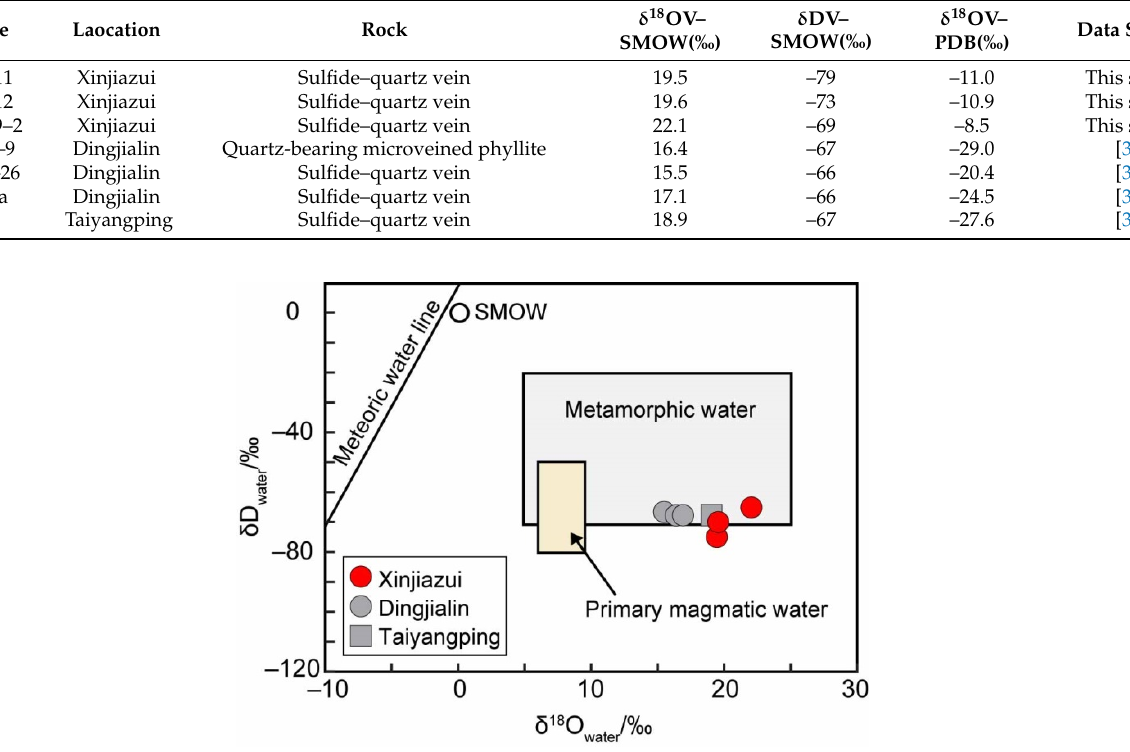
Figure 7. δ DH 2 O and δ 18 OH 2 O values of ore-forming fluids measured or calculated from hydrother- mal quartz. Fields for magmatic and metamorphic waters are from Taylor (1973) [31]. Table 4. Oxygen and hydrogen isotopic composition of quartz from the Xinjiazui, Dingjialin, and Taiyangping gold deposits.